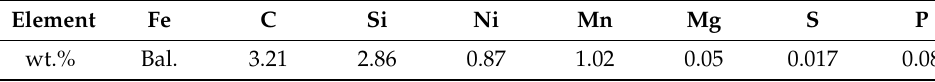
Table 1. Chemical composition of spheroidal graphite iron MN. Element Fe